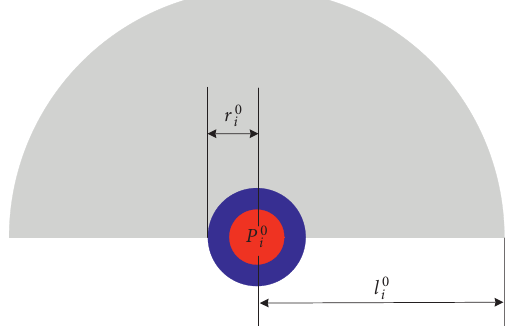
Figure 2: Space limitation of taking avoiding